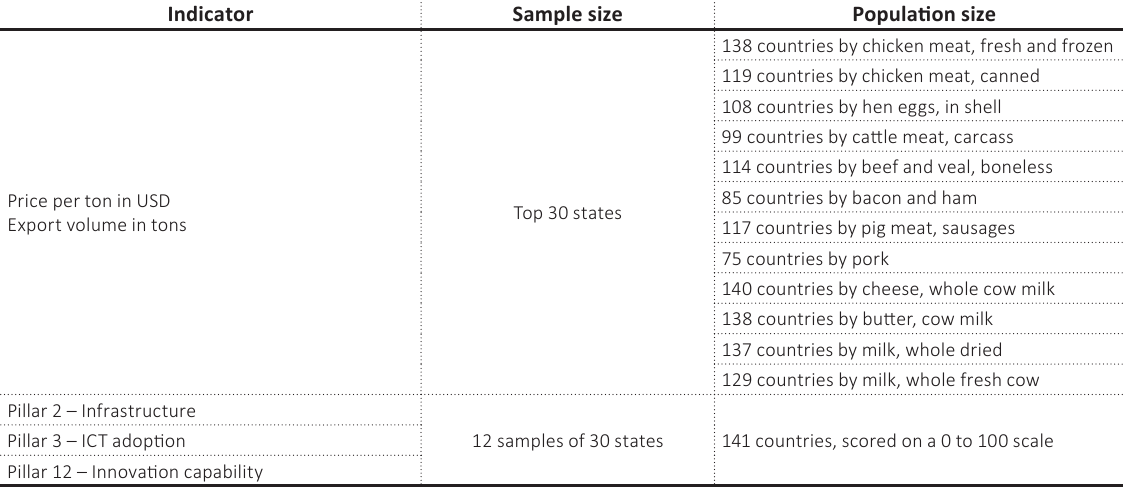
Source: Composed by the